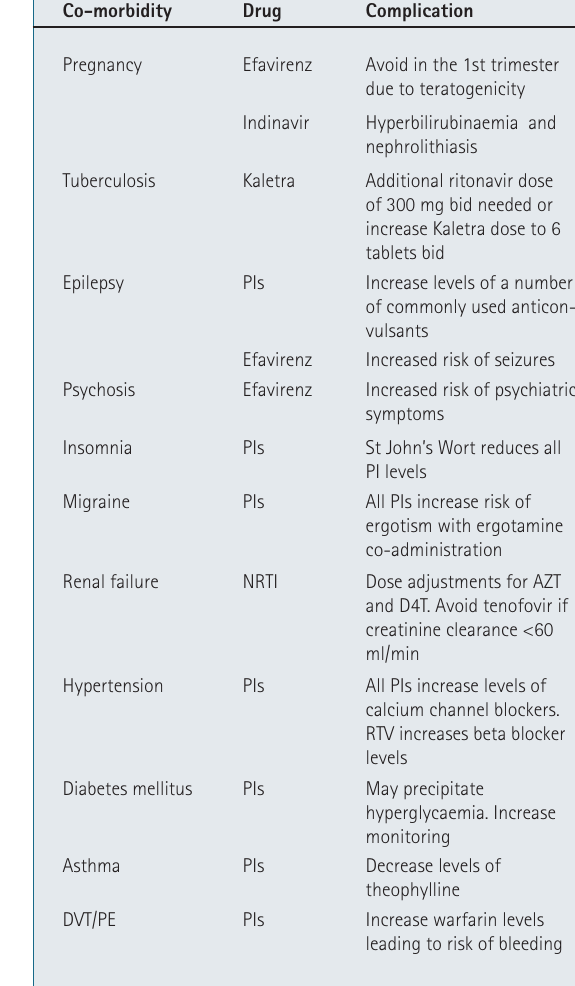
tabLe iii. Co-morbiDitieS aFFeCtinG ChoiCe